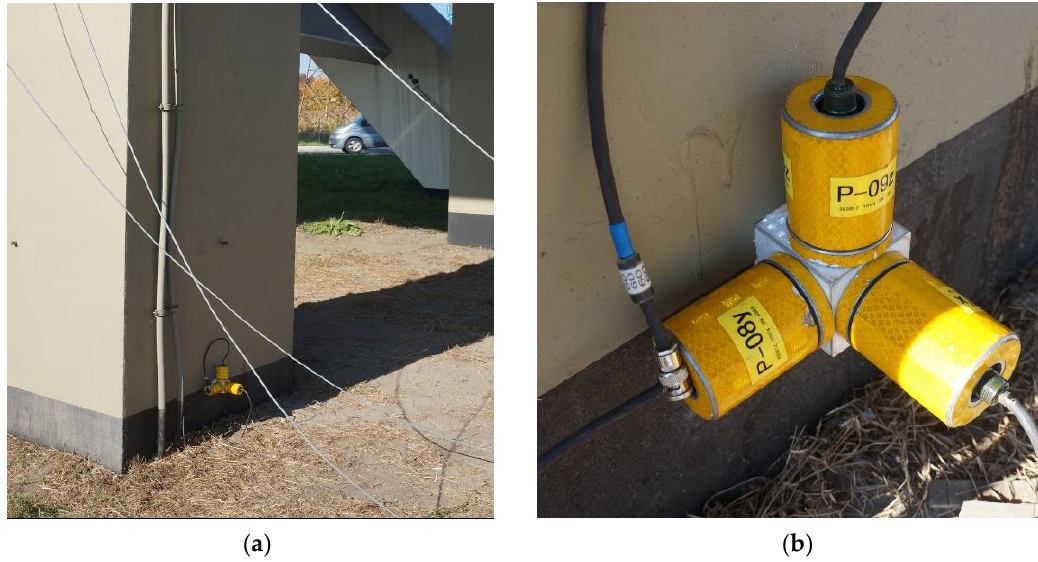
Appl. Sci. 2022 , 12 , x FOR PEER REVIEW Figure 5. Vibroseis location during in situ tests. Figure 5. Vibroseis location during in situ tests.